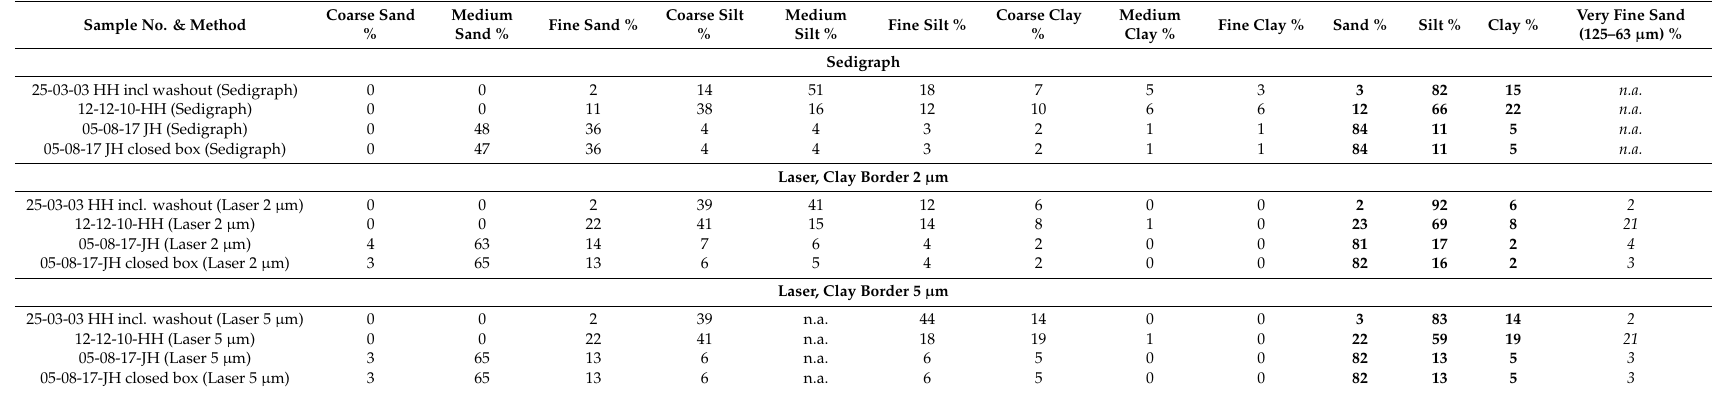
Table A8. Comparison of results of particle size analysis of sediment samples collected during current dust storms by wet sieving and Sedigraph with the Malvern Mastersizer 3000 laser device, applying clay-silt borders of 2 and 5 µ m for laser